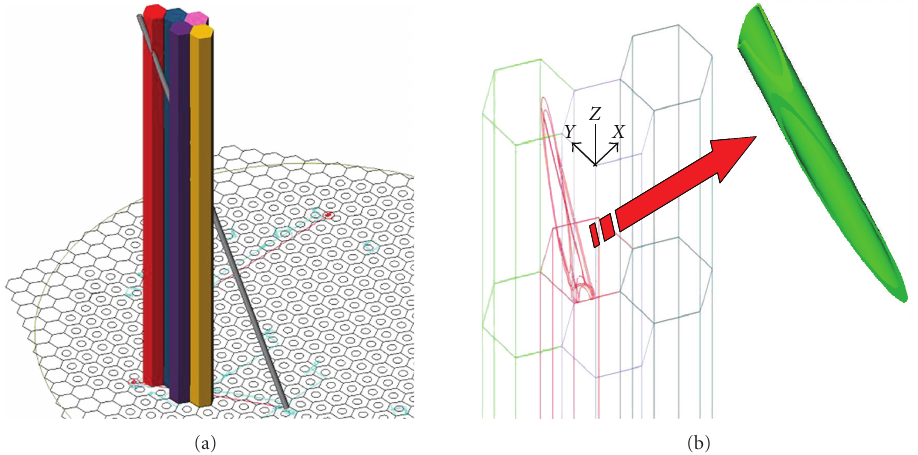
Figure 7: Sketch of a CR and its crossing with 3D NK hexagonal cells.